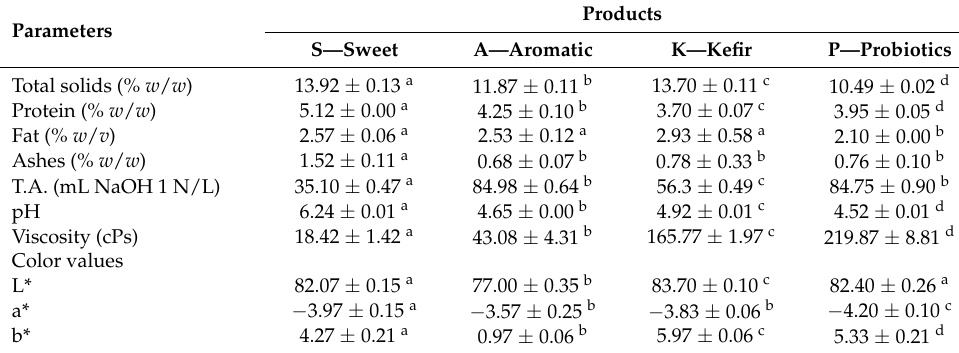
Table 6. Physicochemical characteristics of sheep’s buttermilks produced with sweet cream and with cream fermented with different starter cultures. Different superscript lowercase letters in each row (a,b,c,d) indicate significant differences ( p < 0.05) between products. (T.A. = titratable acidity).